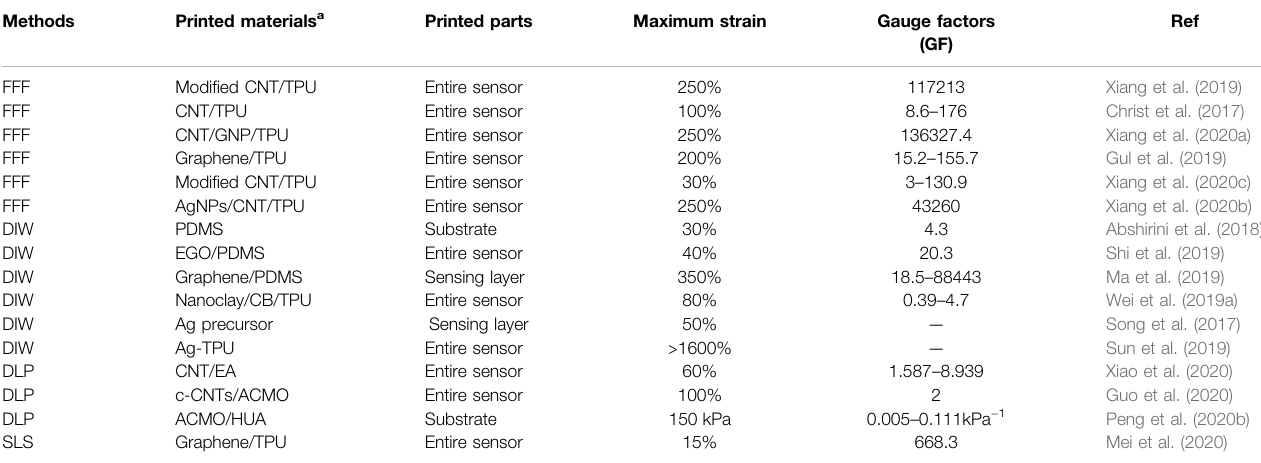
TABLE 2 | 3D-printed strain